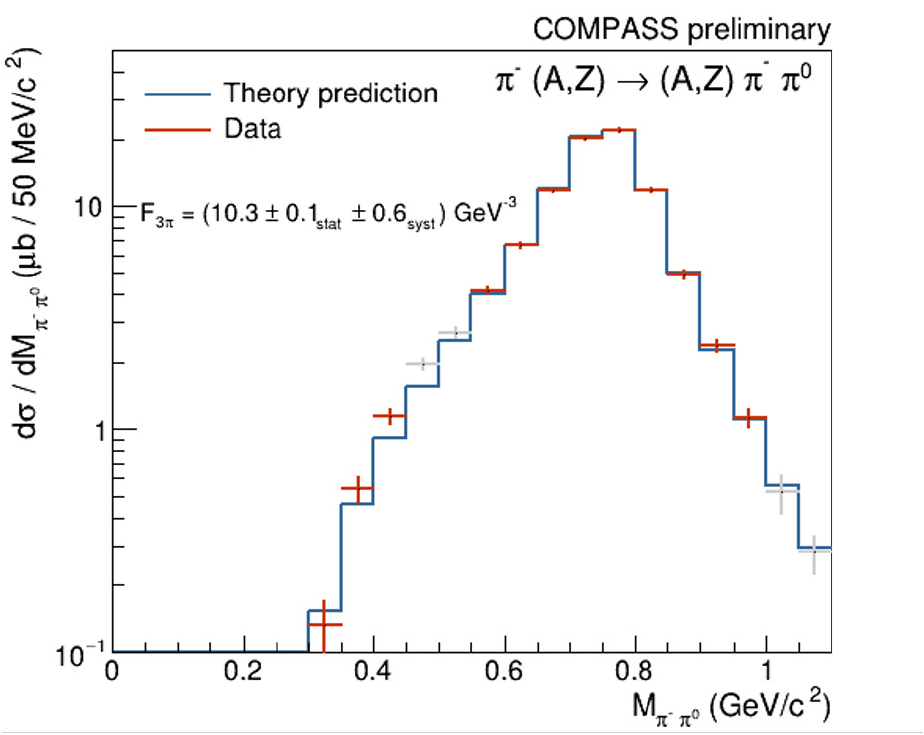
Figure 6. The preliminary COMPASS result for the measurement of the cross section of the process πγ → ππ , in bins of the invariant mass. The background is subtracted as explained in the text. The data are drawn in red points with their total uncertainties. The fit of the used theory framework is indicated as blue line. The region a ff ected by decay of beam Kaons into the same final state is excluded in the fit, the respective data points shown in